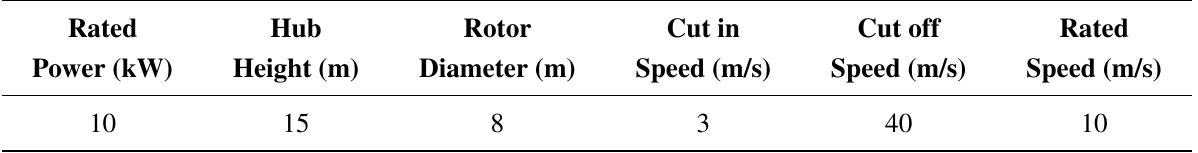
Table 1. Specifications of wind turbine used in the system.